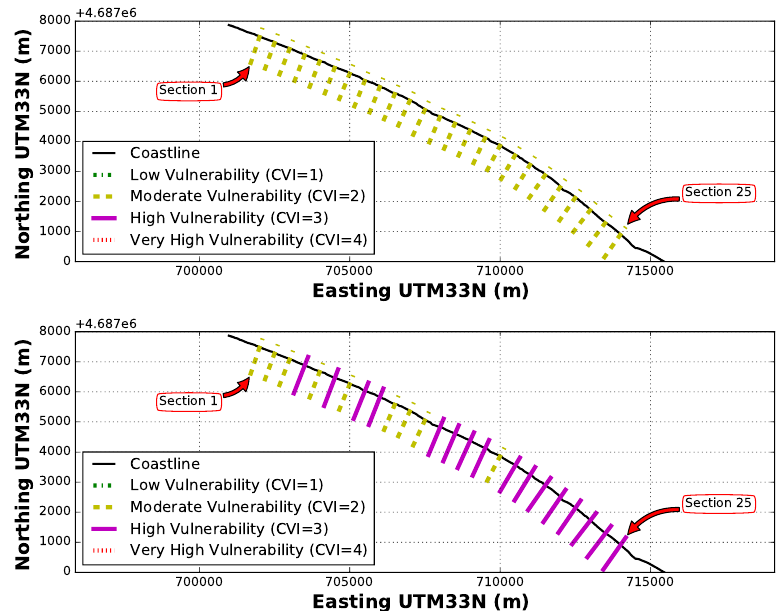
Figure 7. Coastal Vulnerability Index (CVI) for all the considered cross-sections by using local-scale data ( upper panel ) and national-scale data ( lower panel ) evaluated by excluding the factor F A (i.e., extension of the flooded area). Section numbering, from 1–25, starts from